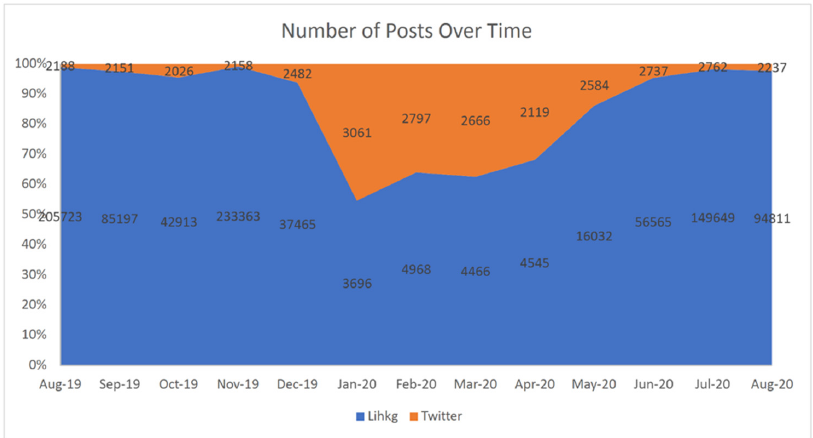
Figure 4. Number of posts released on Lihkg and Twitter over time.